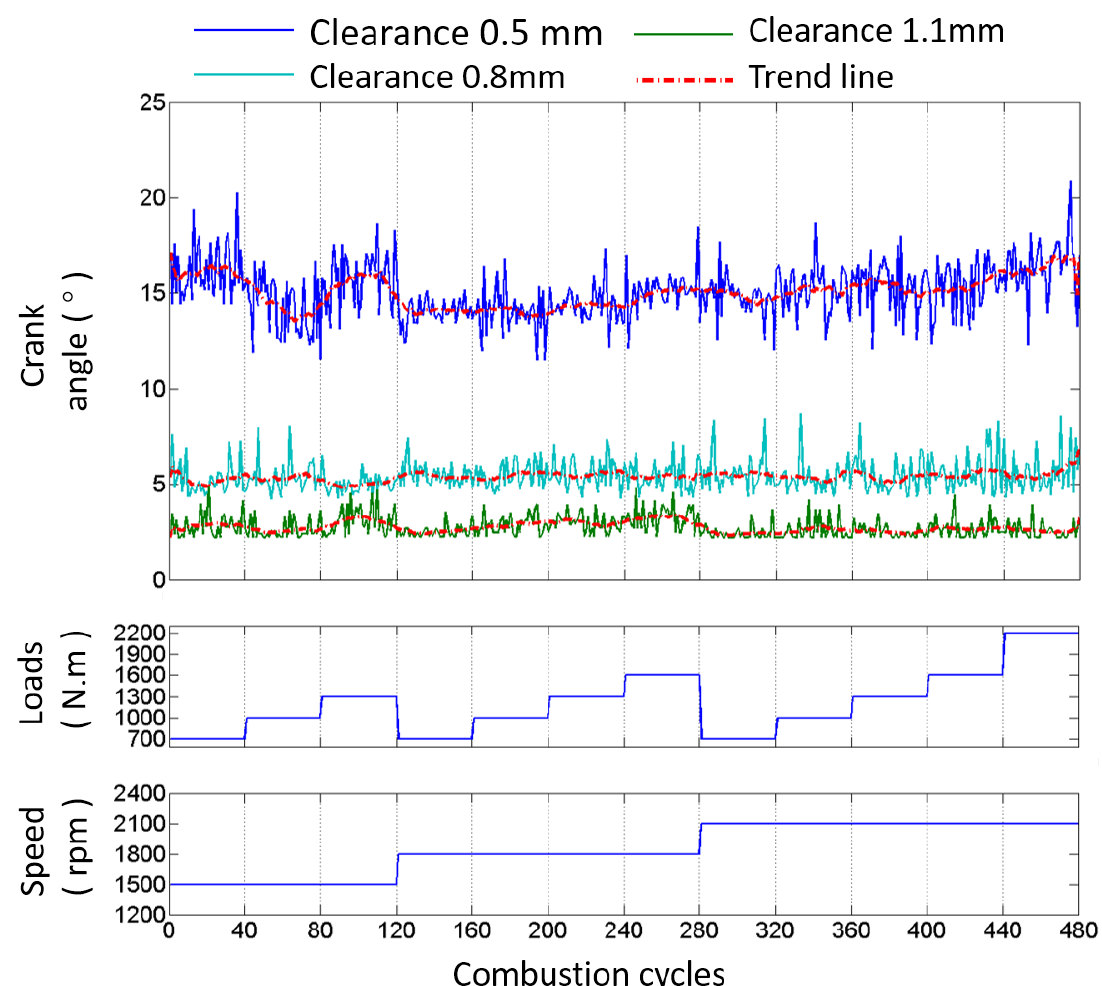
Figure 17. Angle and range fluctuations of the commencement of B1-cylinder exhaust valve closing impact in 480 combustion cycles calculated by the presented method with different valve clearances.